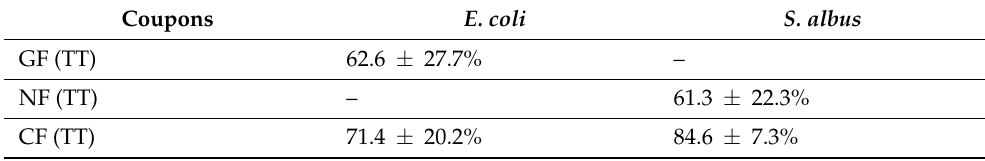
Table 2. Bacteriostatic rates of tested filter materials treated with triclosan (a: E. coli , b: S. albus ).